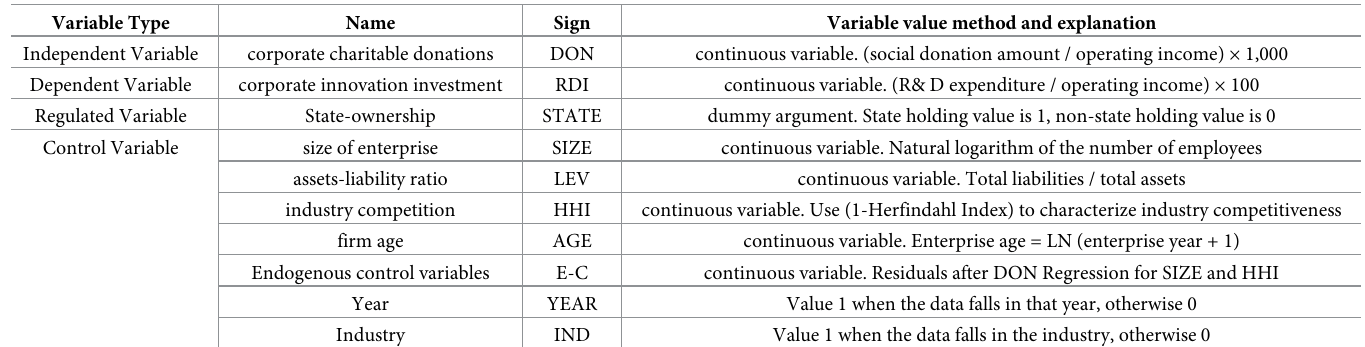
Table 2. Definition and value method of